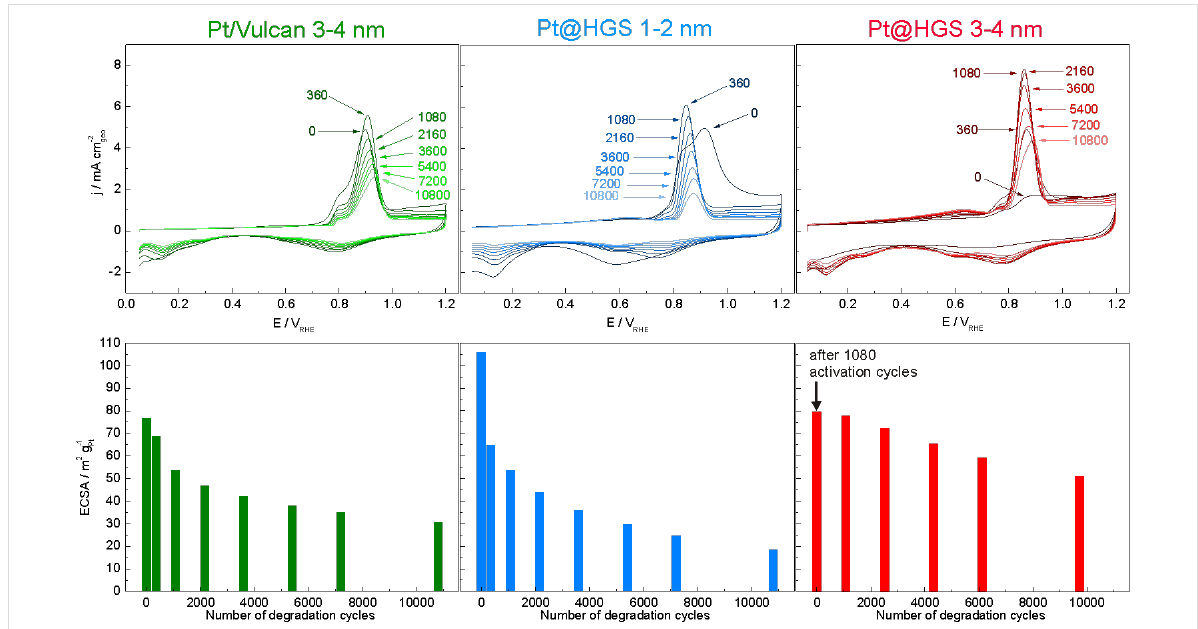
Figure 3: Electrochemical oxidation of a carbon monoxide monolayer (CO-stripping curves) after 0, 360, 1080, 2160, 3600, 5400, 7200 and 10800 degradation cycles for Pt/Vulcan 3–4 nm, Pt@HGS 1–2 nm and Pt@HGS 3–4 nm. The degradation cycles are performed between 0.4 and 1.4 V RHE with a scan rate of 1 V·s − 1 without rotation at room temperature in argon-saturated 0.1 M HClO 4 (not shown). CO-stripping voltammograms (top) were recorded between 0.05 and 1.2 V RHE at a scan rate of 0.05 V·s − 1 to measure the ECSA versus the number of cycles (bottom). The CO-stripping voltammograms of Pt@HGS 3–4 nm are reprinted with permission from [71]. Copyright 2012 American Chemical